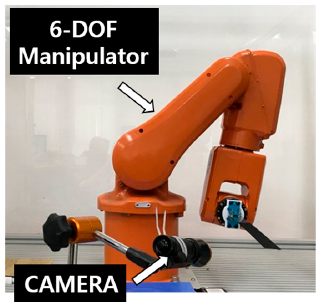
Figure 8. Experimental setup.